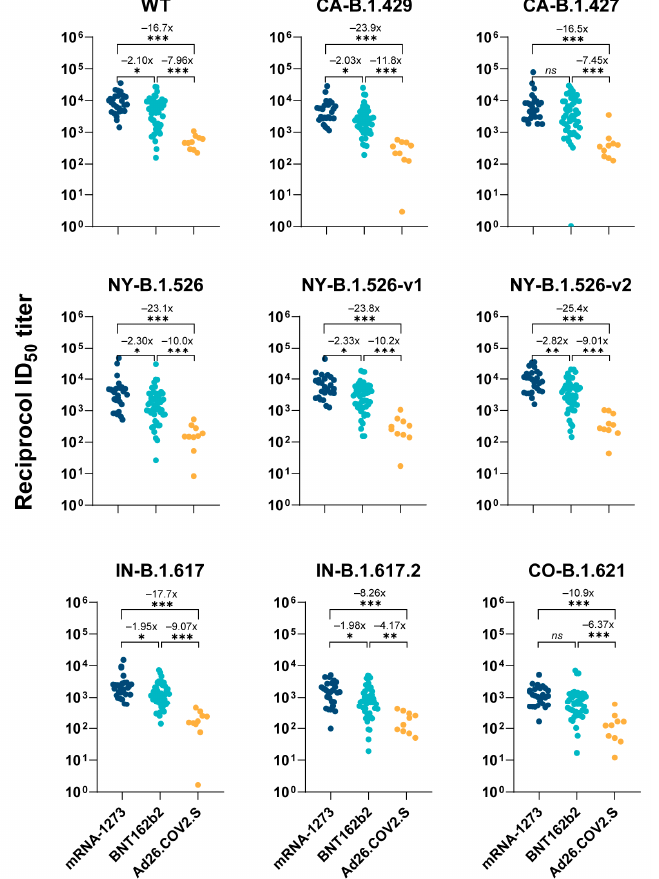
Figure 2. Inter-vaccine comparison of ID 50 values for each variant. Plasma obtained from mRNA-1273-, BNT162b2- or Ad26.COV2.S-vaccinated subjects were collected. Neutralization was measured with recombinant vesicular stomatitis virus (rVSV)-based pseudovirus-bearing spike proteins of SARS-CoV-2 WT or the variants. The reciprocal neutralizing titers at a 50% inhibitory dilution (ID 50 , units = 1/dilution) against each SARS-CoV-2 variant are calculated for each donor and plotted in figure to compare among vaccine groups. A Kruskal–Wallis one-way ANOVA with Dunn’s Multiple comparisons test (comparing each column to every other column) was used to evaluate for statistical significance, which is defined as follows: ns ( p > 0.05), * ( p ≤ 0.05), ** ( p ≤ 0.01), and *** ( p ≤ 0.001). The numbers above asterisks indicate fold changes of geometric mean ID 50 values between two groups (the pairwise comparisons). GraphPad Prism version 9.1.1 was used for all statistical